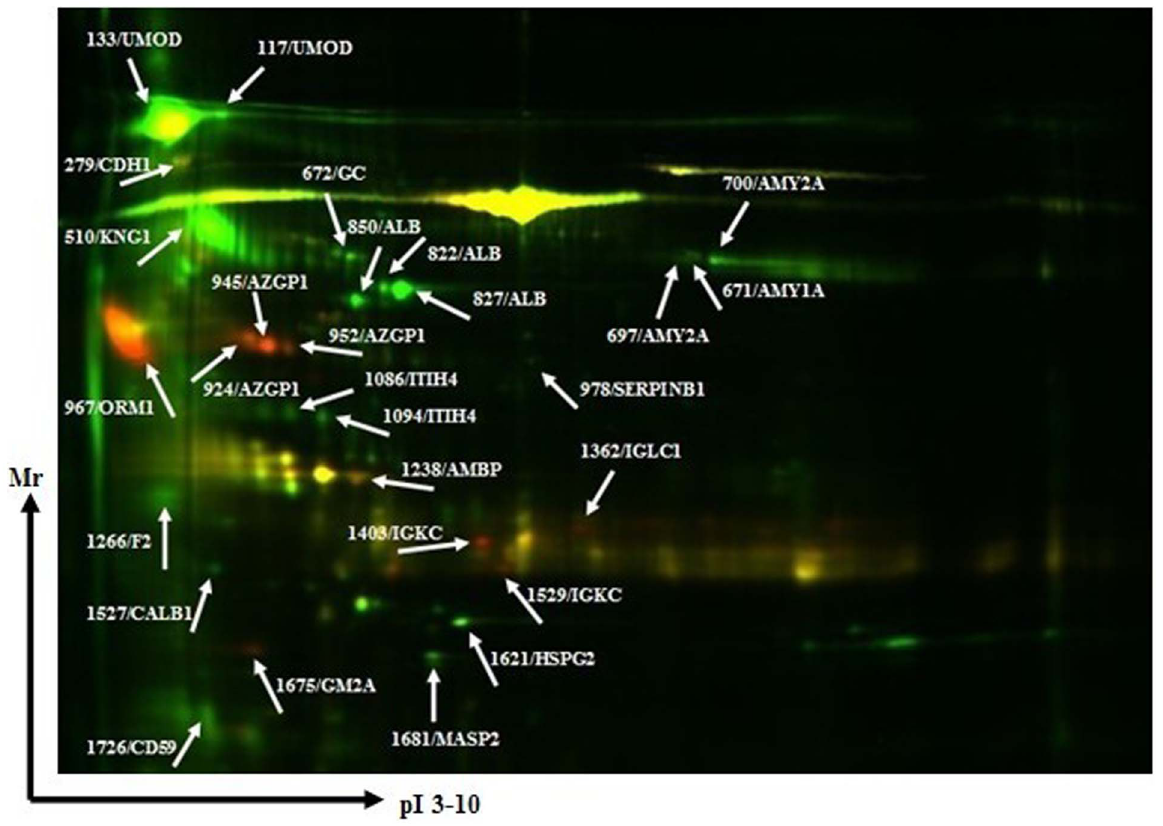
Figure 1. Distribution of all 28 differentially expressed protein spots in a representative two- dimensional fluorescent differential gel electrophoresis (2D-DIGE) image from proteomic profiling of urine samples from patients with CHF and healthy controls. Further identified protein spots are indicated by spot ID. Protein spots, protein name and spot ID are indicated (arrows). doi:10.1371/journal.pone.0107550.g001 PLOS ONE |